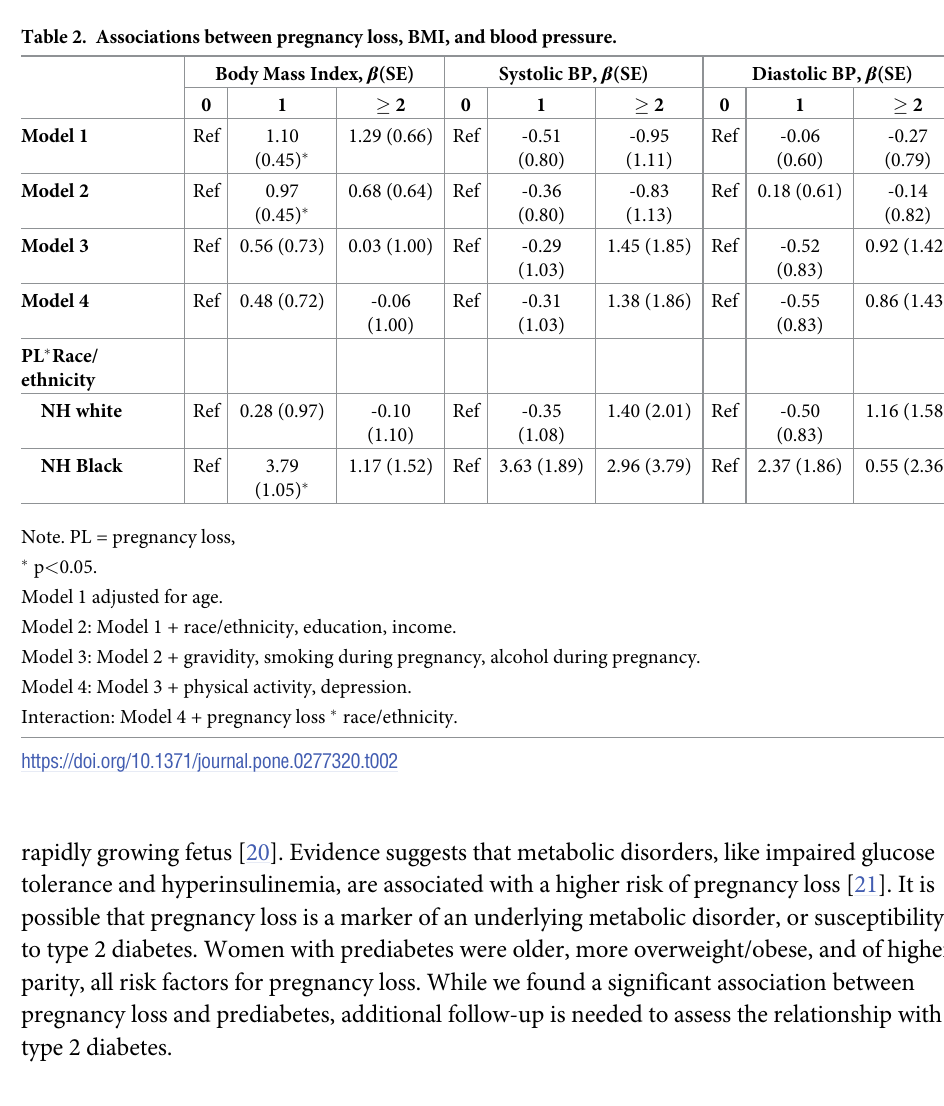
Table 3. Associations between pregnancy loss, hyperlipidemia, and diabetes status. Hyperlipidemia vs. None (OR, 95%